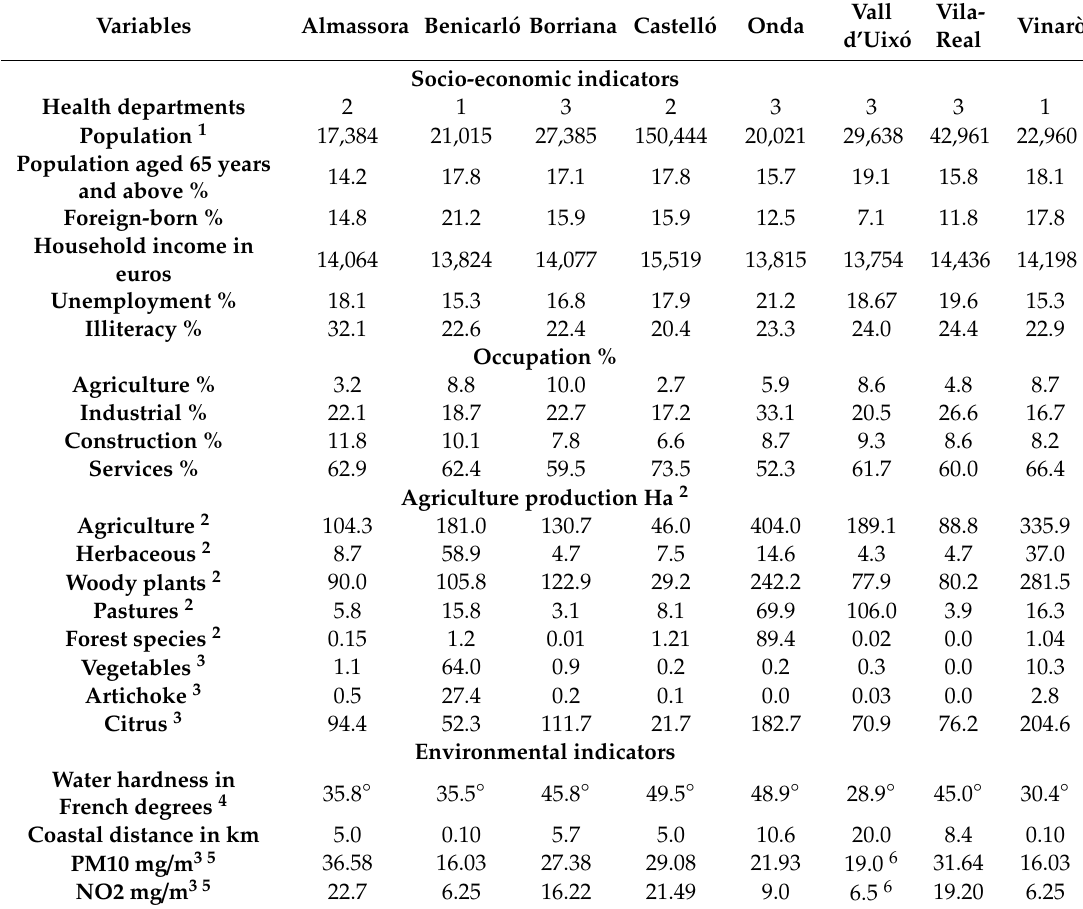
Table 1. Socio-economic characteristics of the eight municipalities, agricultural production in hectares per 1000 inhabitants, and environmental indicators (Castell ó n, 1991–2011